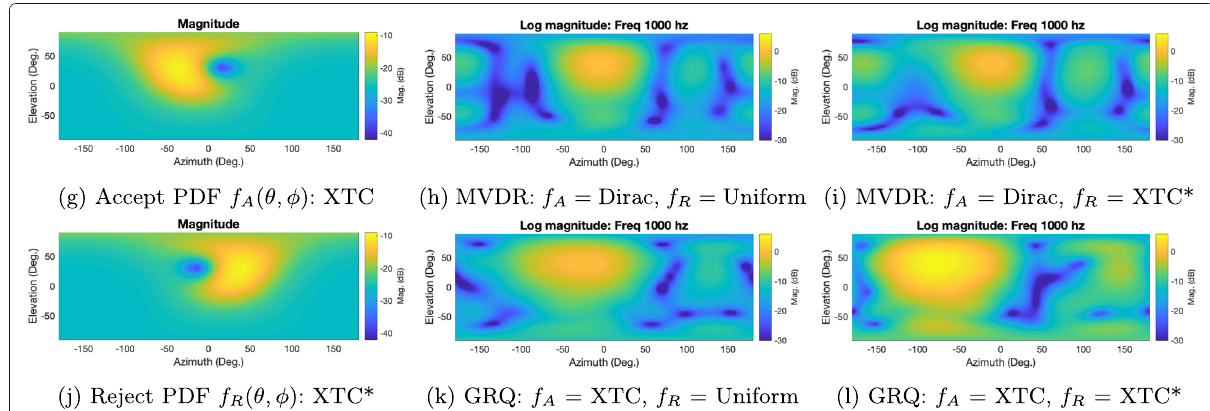
Fig. 5 Beampatterns are shown for MVDR / GRQ beamformers designed from a combination of spatial priors for cross-talk cancelation. Dirac and uniform density functions cause over-fitting to the ipsilateral response and under-fitting to the contralateral response respectively unlike the XTC and XTC*